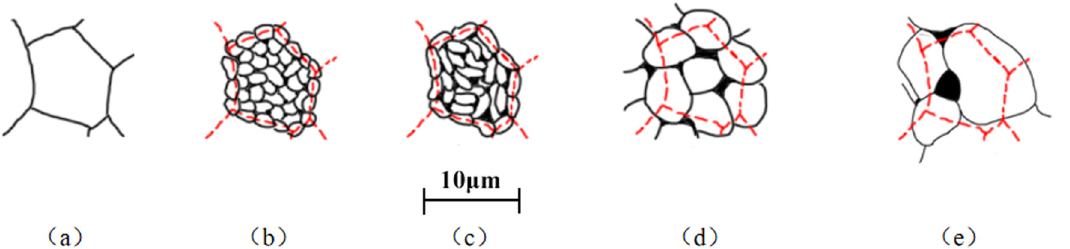
Figure 7: Schematic diagram of nucleation and growth of CaO grain. ( a ) CaCO 3 crystal; ( b ) CaO crystal formed on the CaCO 3 crystal during decomposition; ( c – e ) CaO crystal growth and the pores - merging process, where the white box represents the crystal and the black area represents the internal pores of